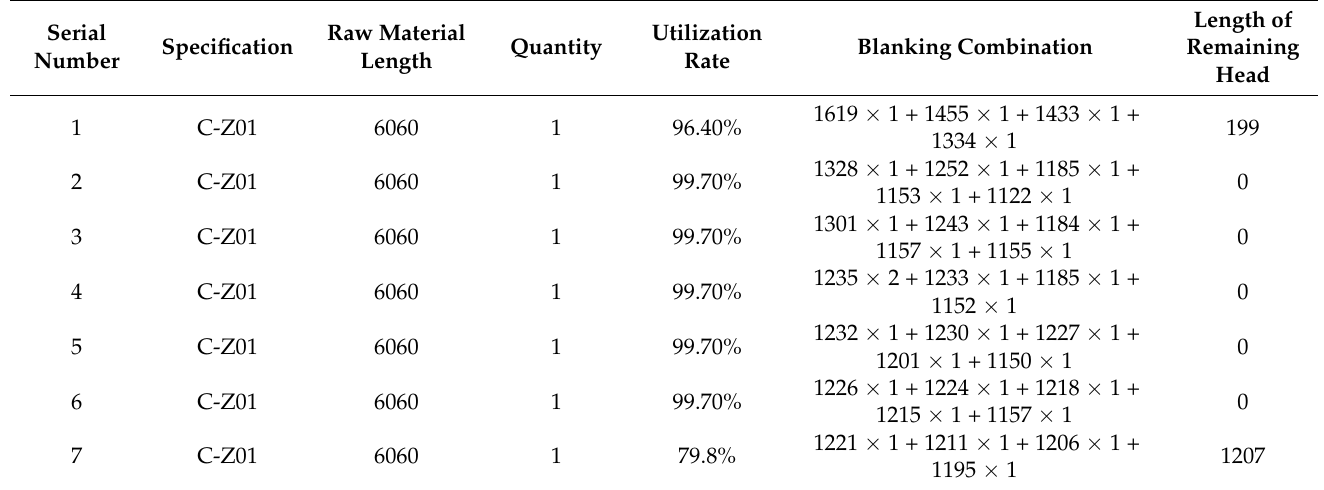
Table 12. C-Z01 keel blanking combination.